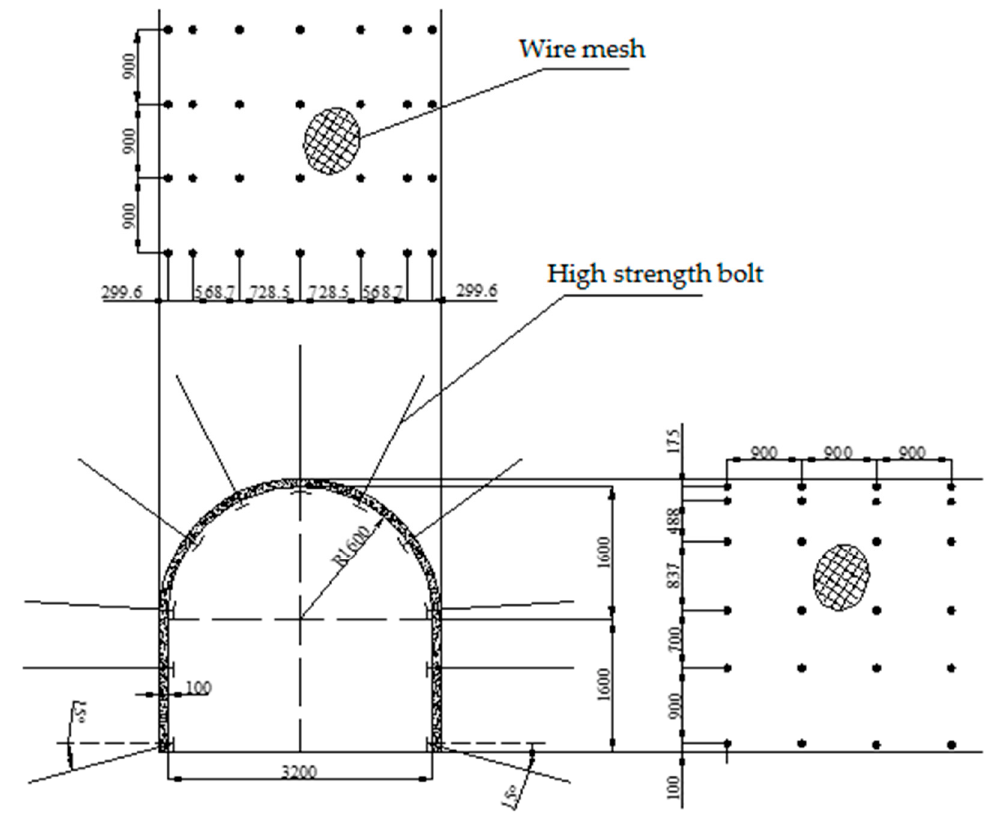
Figure 15. Bolt-shotcrete net support structure of the test roadway (mm).